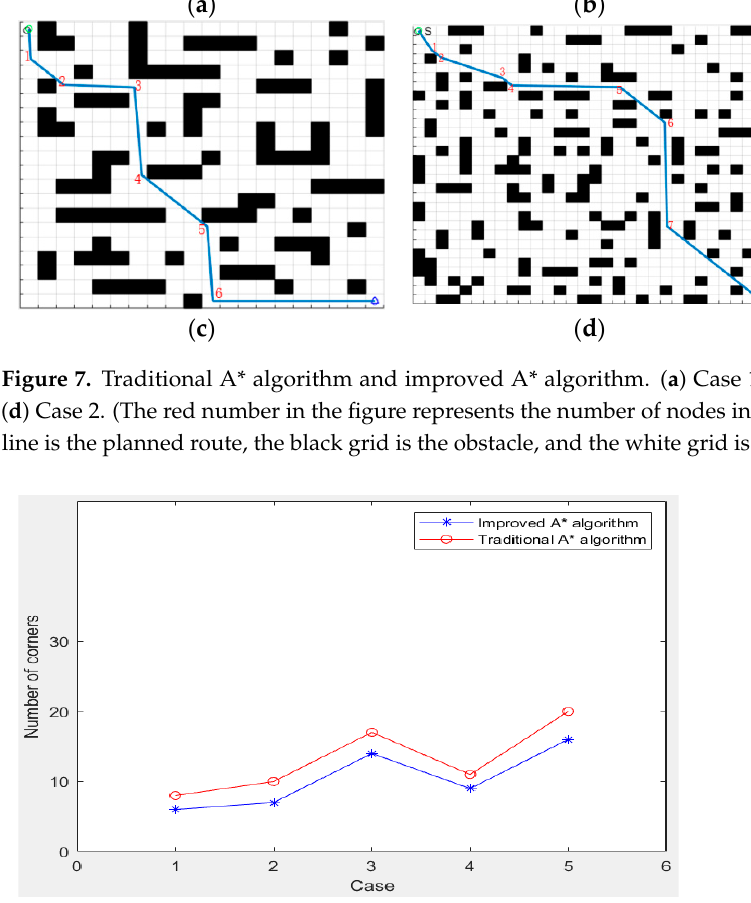
( b ) Figure 9. Path-smoothing experiments. ( a ) traditional algorithms, ( b ) smooth processing path. 6.3. A-OP Algorithm Simulation Experiment The fusion algorithm designed in this paper enables the mobile robot not only to complete global path planning, but also to achieve local planning to avoid obstacles. The fusion algorithm was simulated in 20 × 20 and 40 × 40 maps. Static and dynamic obstacles were added to the map, and the simulation results of the fusion algorithm are shown in Figure 10. Figure 10a,b shows the experiments in different environments. The black dashed line is the planned path of the improved A* algorithm, and the blue solid line is the planned path of the fusion algorithm.